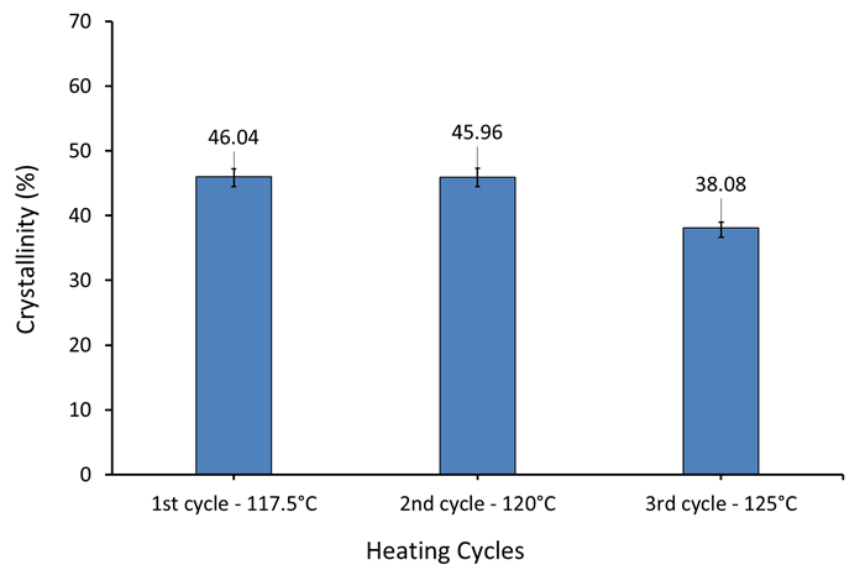
Figure 11. Influence of heating on the crystallisation of the UHMWPE (DSC measurements).